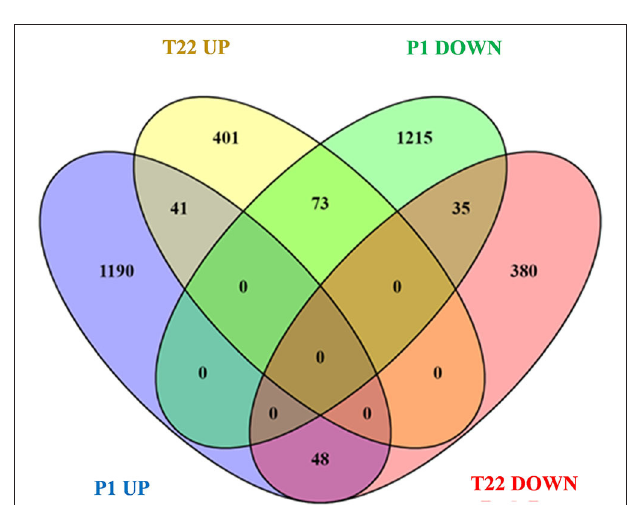
( Table 2 ): ethylene-responsive transcription factor, TINY, ethylene-responsive transcription factor, MYB transcription factor 31, and AP2/EREBP transcription factor. In addition,